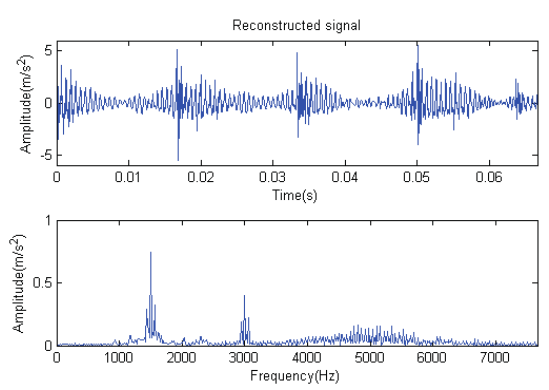
Figure 26. Reconstructed